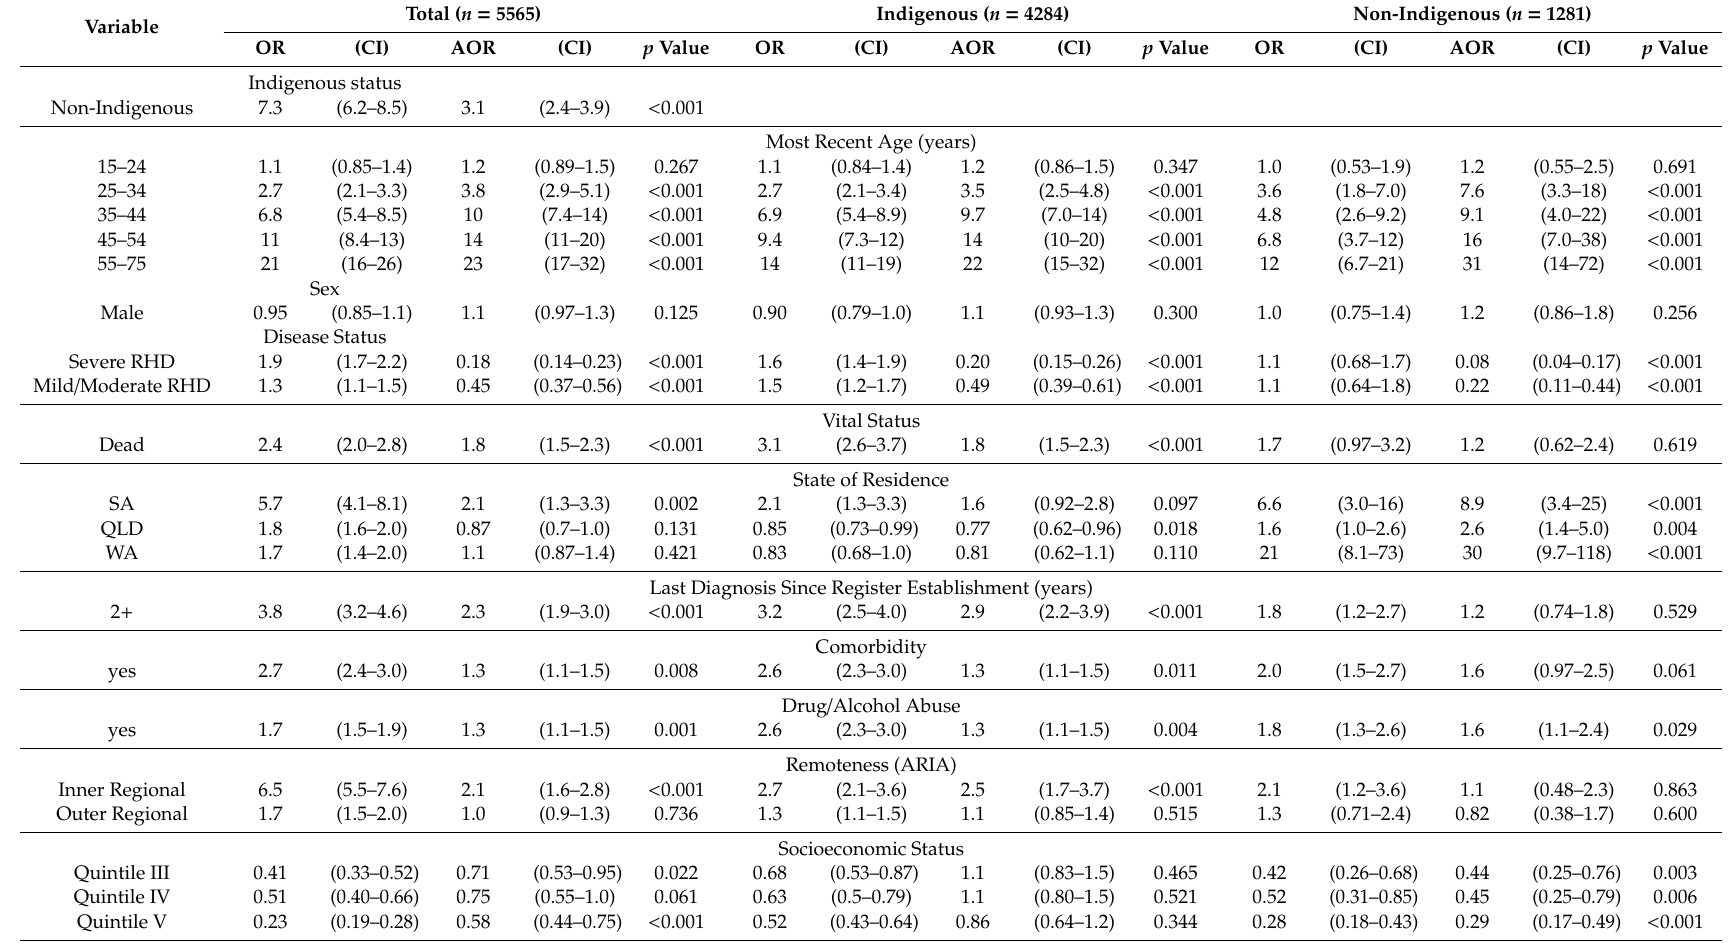
Table 4. Multivariate inferential analysis of ARF and RHD cases only found in the hospital